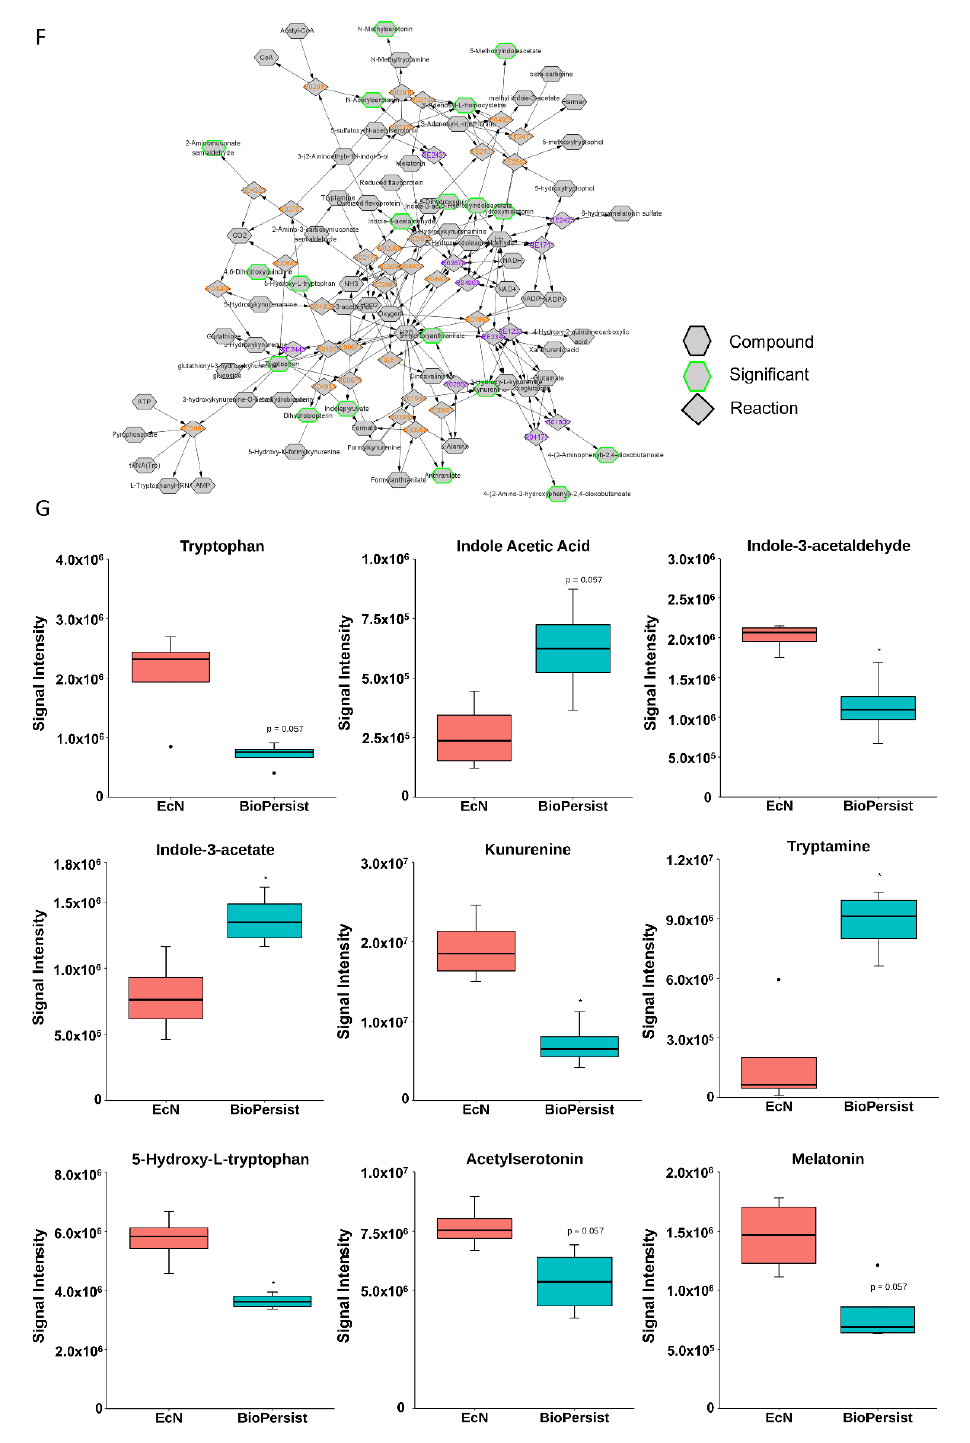
Figure 4. BioPersist decreases production or stress hormones and increases tryptophan derived anti-stress hormones. ( A ) Subnetwork of C21-steroid hormone biosynthesis and metabolism pathway. Metabolites highlighted in green indicated statistically significant features. ( B ) Summary of differential expressions of hormones between mice treated with EcN and BioPersist. ( C ) Concentrations of major stress hormones including cortisone, corticosterone, noradrenaline, adrenaline, aldos- terone, testosterone, androsterone, and histamine in mice treated with EcN and BioPersist. ( D ) Serotonin and acetylcholine concentration in mice treated with EcN and BioPersist. ( E ) Schematic summary of three major tryptophan-derived pathways. ( F ) Subnetwork of the tryptophan metabolism pathway. Metabolites highlighted in green indicated statistically significant features. ( G ) Individual metabolites involved in tryptophan degradation pathways. n = 4 per group. * p <